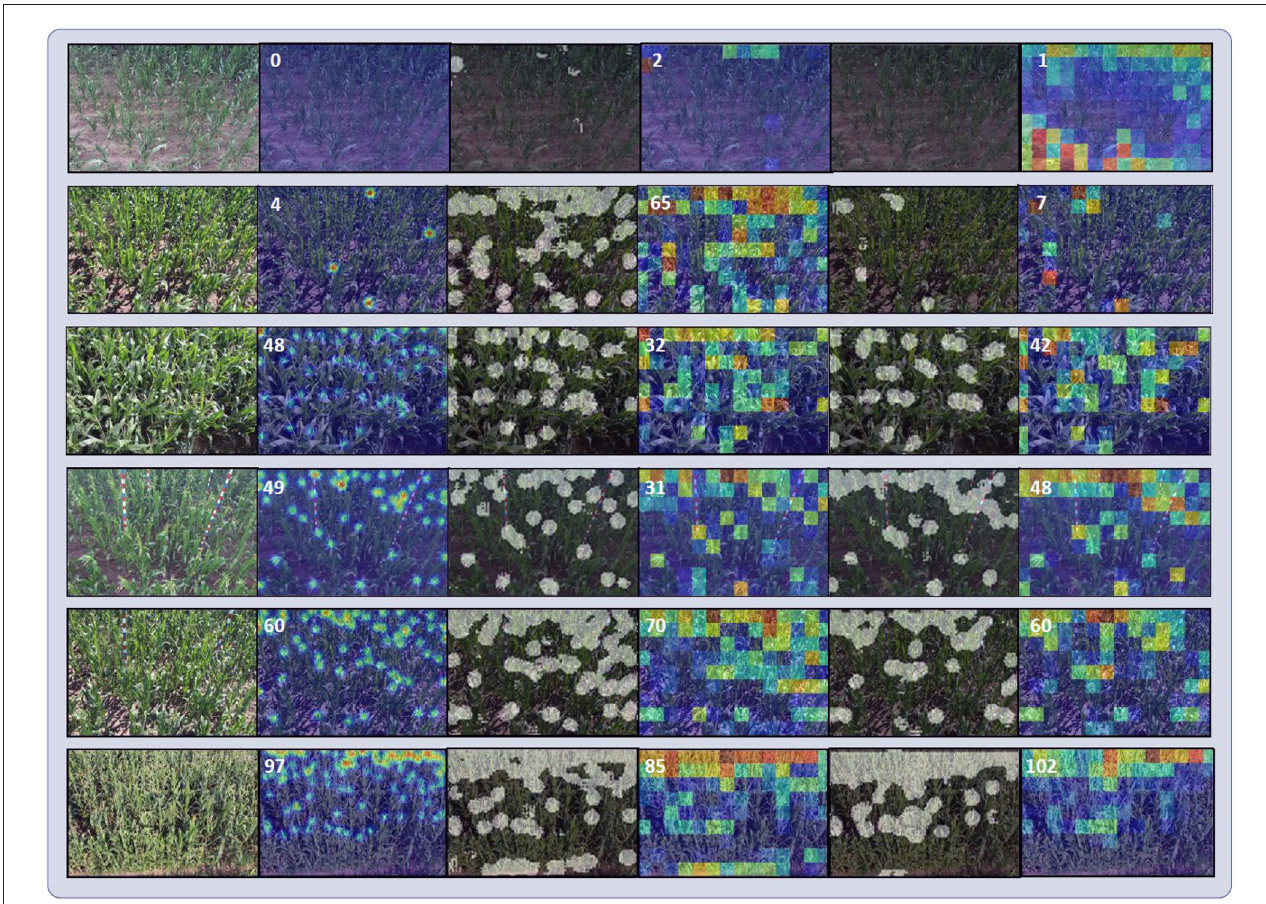
FIGURE 9 | Visualizations of model with and without discriminators. From left to right are input images, ground truth density maps, estimated foreground mask without discriminators, estimated local count maps without discriminators, estimated foreground masks with discriminators, estimated local count maps with discriminators. The foreground masks have been binarized. The white numbers on the corners of ground truth density maps and estimated local count maps denote the ground truth counts and the inferred counts, respectively.